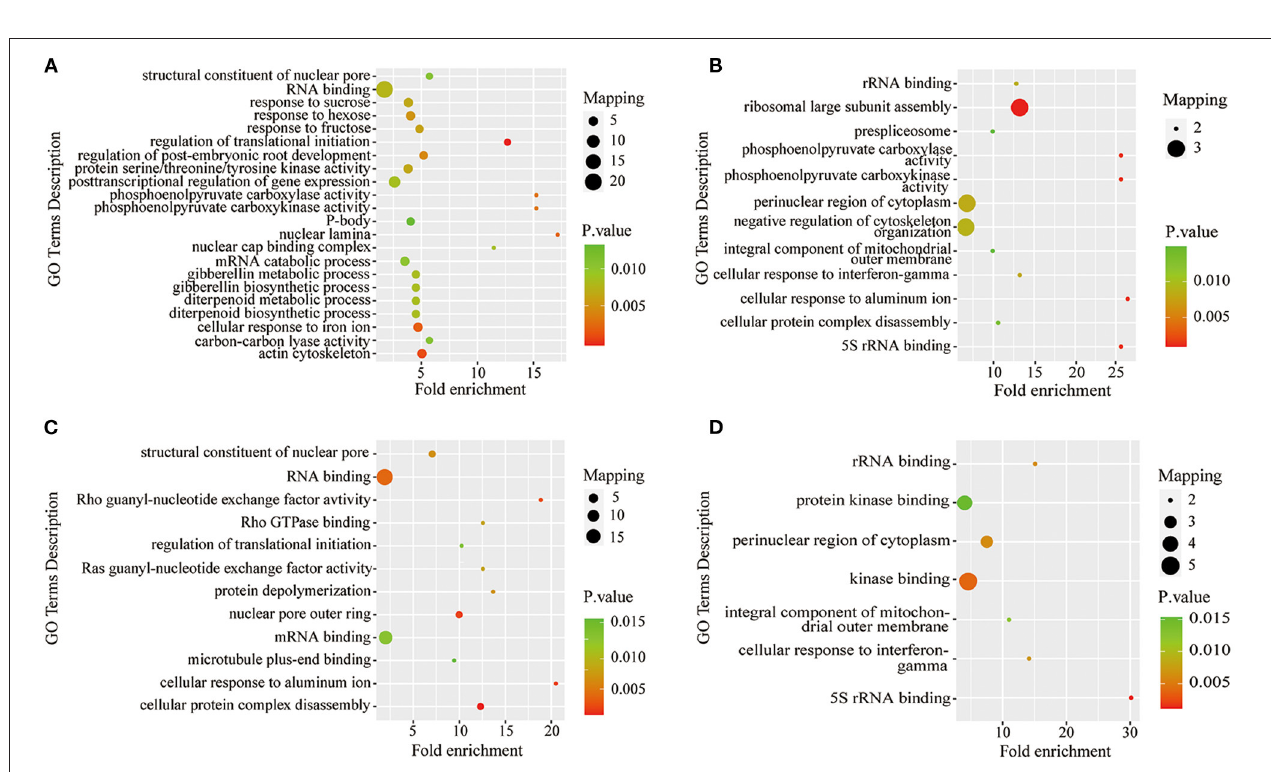
FIGURE 6 | GO enrichment analysis of DPPs in roots under Pi starvation for 6 and 48h, and Pi resupply for 6 and 48h. DPPs, differentially phosphorylated proteins. (A) GO enrichment analysis of P6/CK; (B) GO enrichment analysis of P48/CK; (C) GO enrichment analysis off R6/CK; (D) GO enrichment analysis of R48/CK.